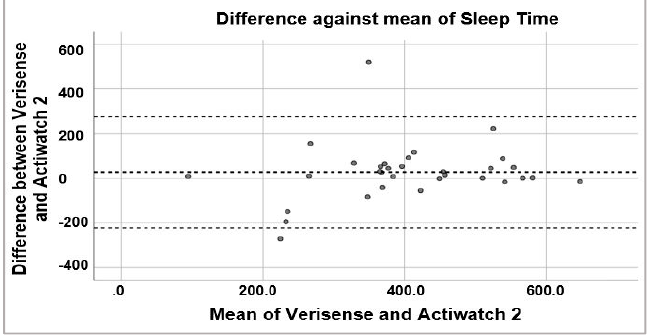
Figure 6. Bland–Altman plot of sleep times estimated by Verisense as compared to Actiwatch 2.